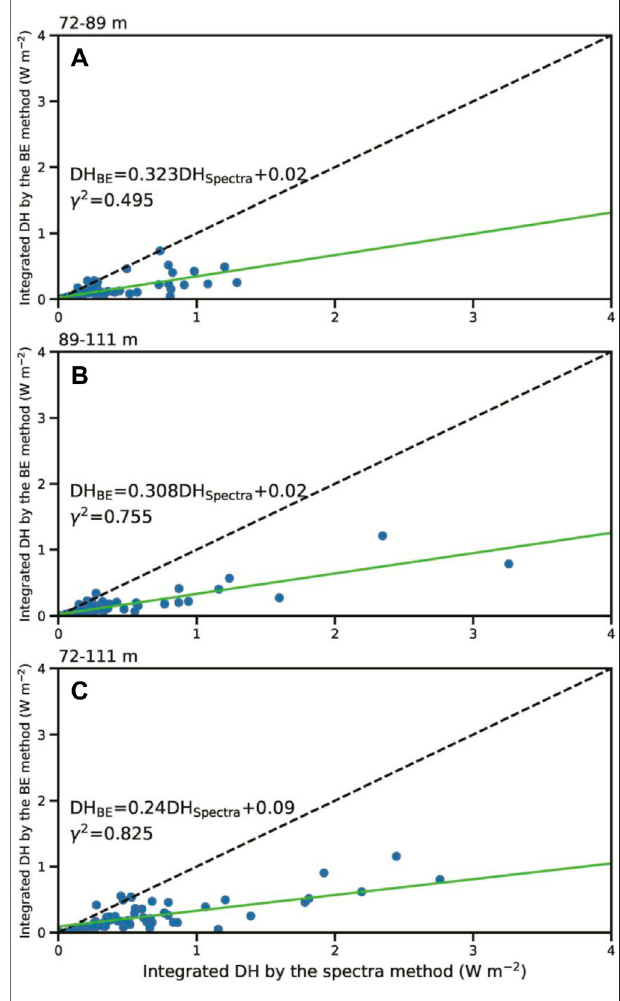
FIGURE 7 | Comparisons between the DH integrated between (A) 72 and89 m, (B) 89and111 m,and (C) 72and111 mbytheBEmethodandthe turbulent spectra method. The black dashed lines represent the 1:1 ratio, and the solidgreen linesrepresenttheleast-squares best fi t.Therelationship equations and coef fi cients of determination are also shown. Note that the samples with good runs simultaneously identi fi ed at both levels are used.